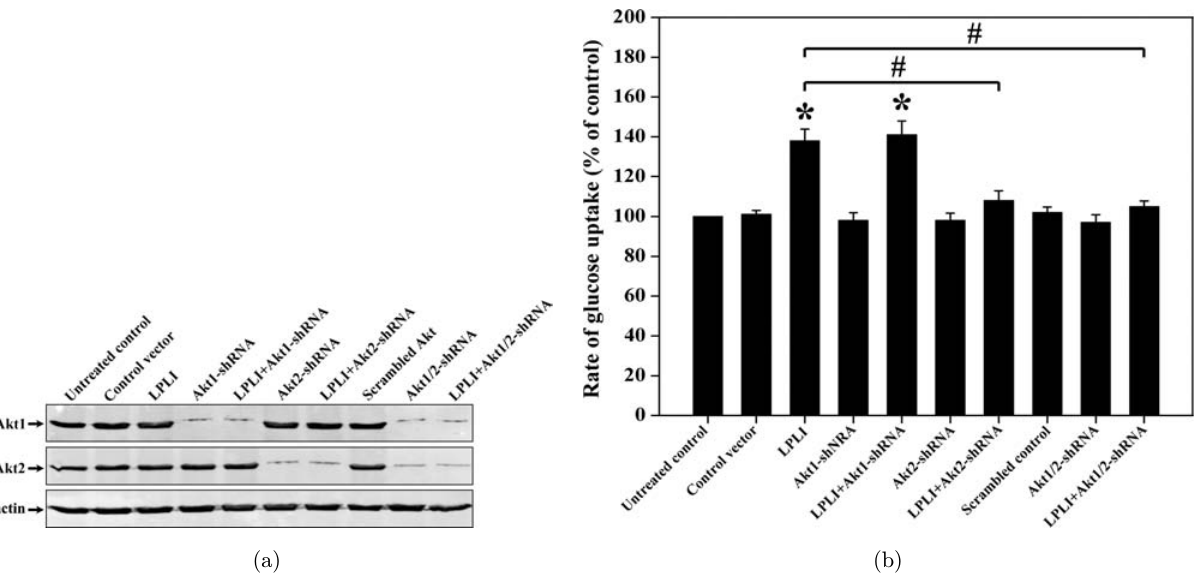
Fig. 4. LPLI induces glucose uptake through Akt2, but not Akt1. 3T3-L1 adipocytes were infected with lentiviral vectors expressing Akt1-shRNA or Akt2 shRNA. Akt1/2-shRNA was transfected into 3T3-L1 adipocyte using X-tremeGENE HP DNA transfection reagent. (a) The expression levels of Akt isoforms (Akt1 and Akt2) were detected with western blot analysis and the e®ects of knockdown of Akt isoforms were shown ( n ¼ 3). (b) After downregulation of Akt isoforms, the 3T3-L1 adipocytes were serum-starved for 6 h and then treated with LPLI at the °uence of 5 J/cm 2 . About 2 h later, the glucose uptake was measured. ( n ¼ 3, * p < 0 : 05 versus untreated group; # p < 0 : 05 versus indicated